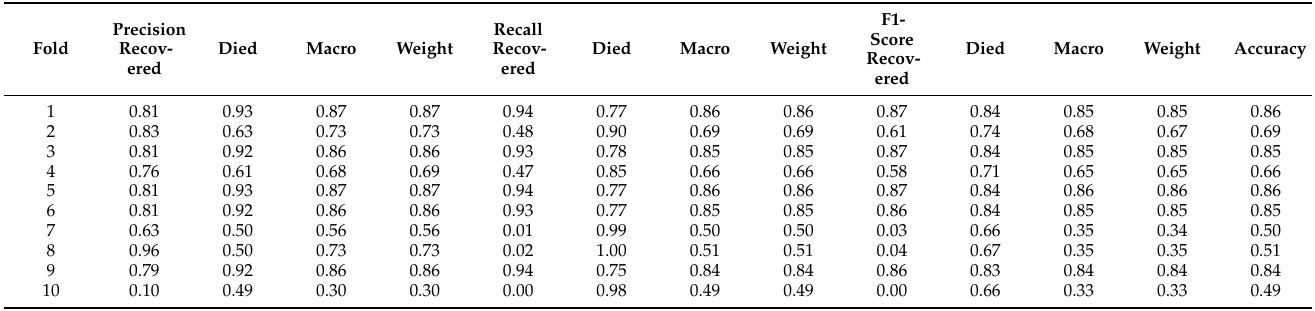
Table 7. Results of the LSTM + CNN proposed model using different evaluation metrics based on a 10-fold cross-validation.